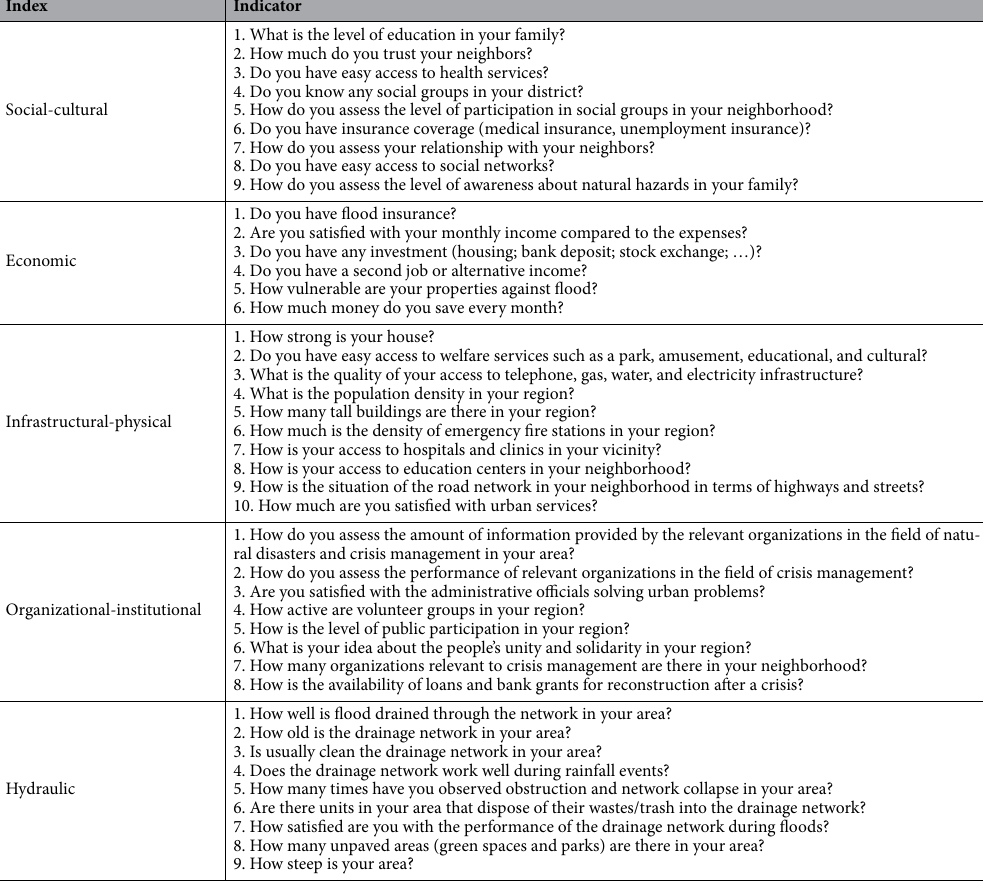
Table 2. Details of the indices and indicators to assess FR in